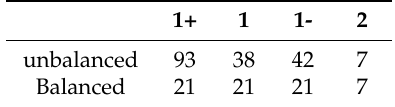
Table 4. Training sample size of tree vitality classification by ALS